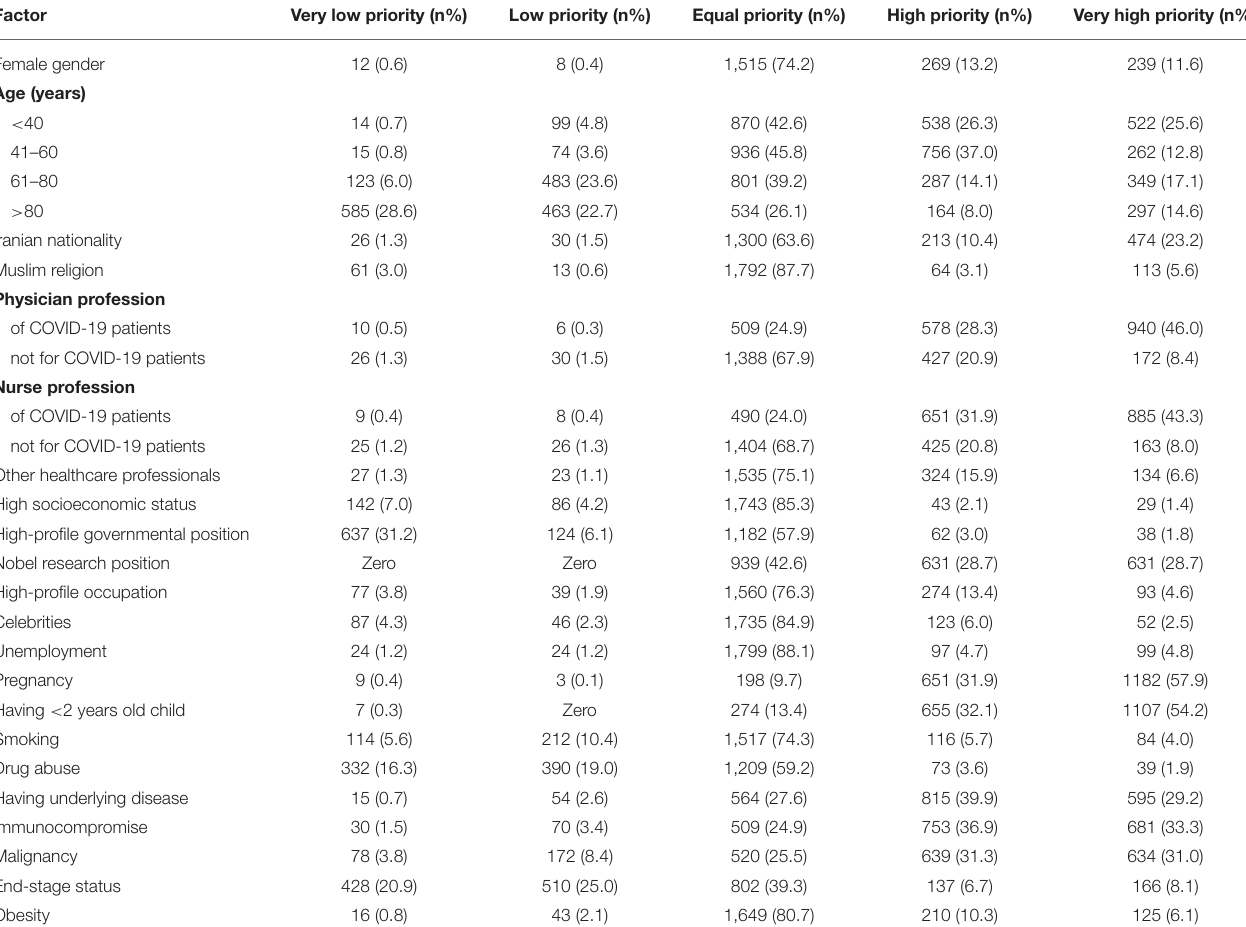
TABLE 2 | Participants’ responses on prioritizing ventilator allocation among sub-groups of patients with COVID-19 who need mechanical ventilation.